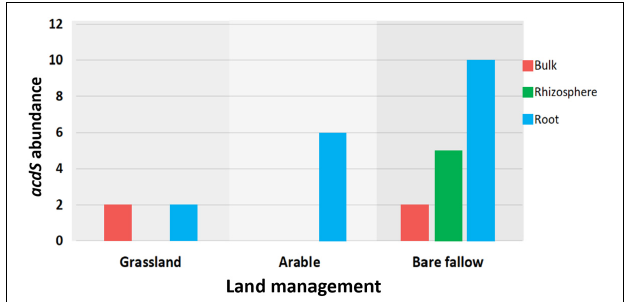
FIGURE 3 | The distribution of the acdS gene abundance across three different land managements. A total of 27 isolates possessed the acdS gene, the bar graph showing its abundance across the different niche compartments of bulk soil, rhizosphere soil, and wheat roots.